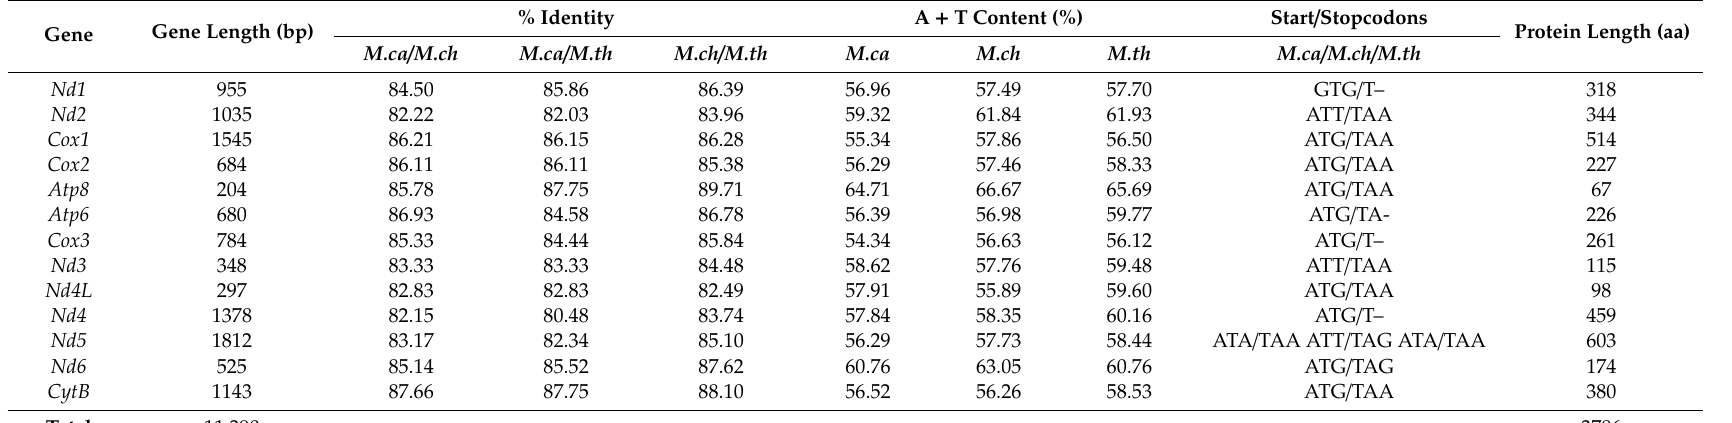
Table 2. Data about the 13 PCG of the three Microtus mitogenomes ( M.ca : M. cabrerae ; M.ch : M. chrotorrhinus ; M.th : M. thomasi